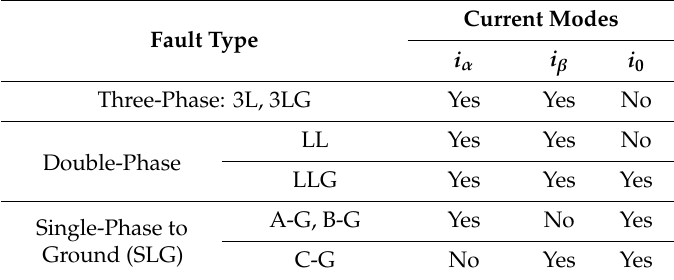
Table 2. Current modes used to detect fault